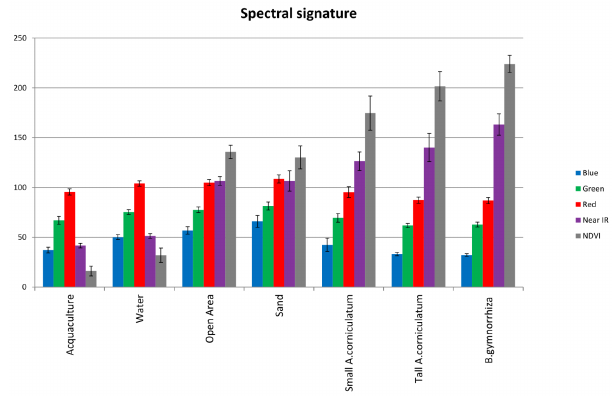
1 Figure 3. Spectral reflectance (intensity of each band) of the land-use/cover classes used for 2 Fig. 3. Spectral reflectance (intensity of each band) of the land- use/cover classes used for supervised classification of Gaoqiao supervised classification of Gaoqiao mangrove and adjacent areas. 3 mangrove and adjacent